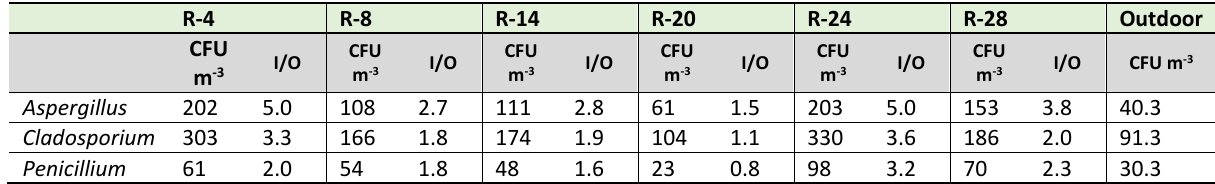
TABLE 2. Concentrations and I/O ratio values for the predominant genera in each naturally ventilated